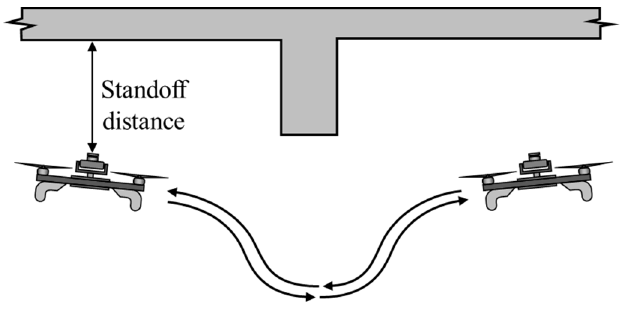
Figure 11. Trajectory of aircraft during the vertical obstacle avoidance test.